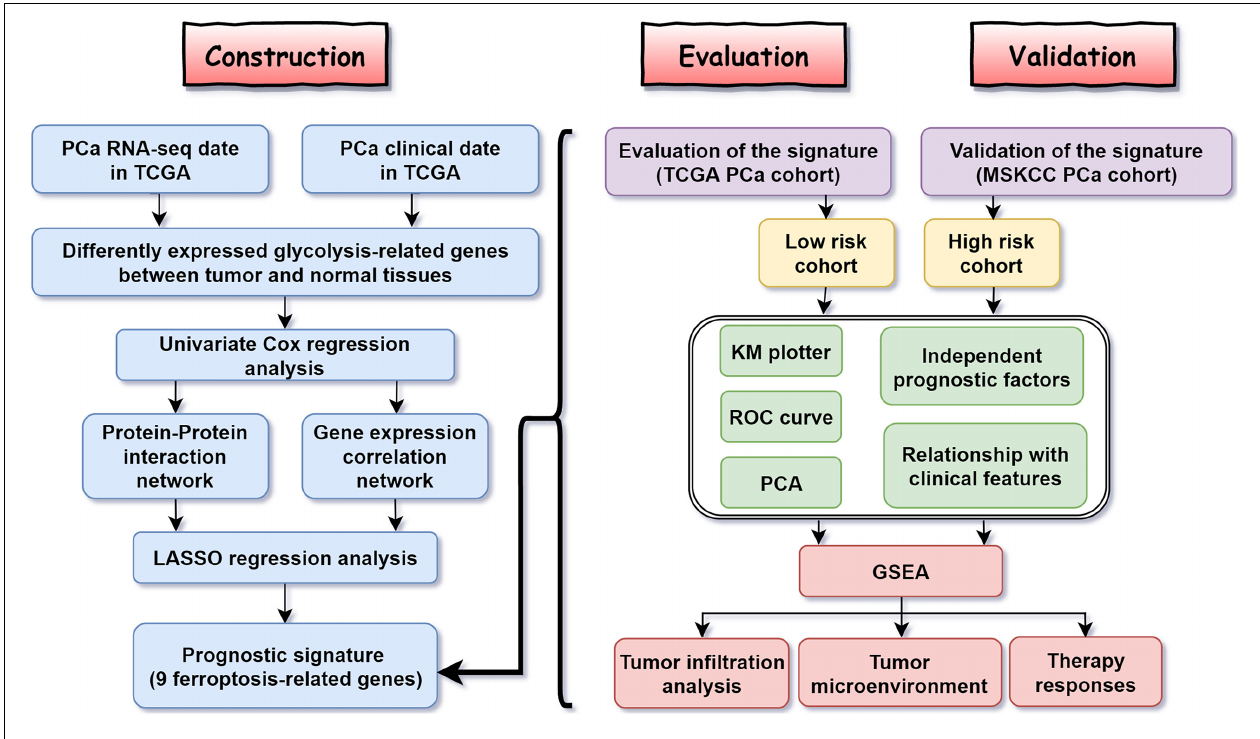
FIGURE 1 | The flow diagram of the